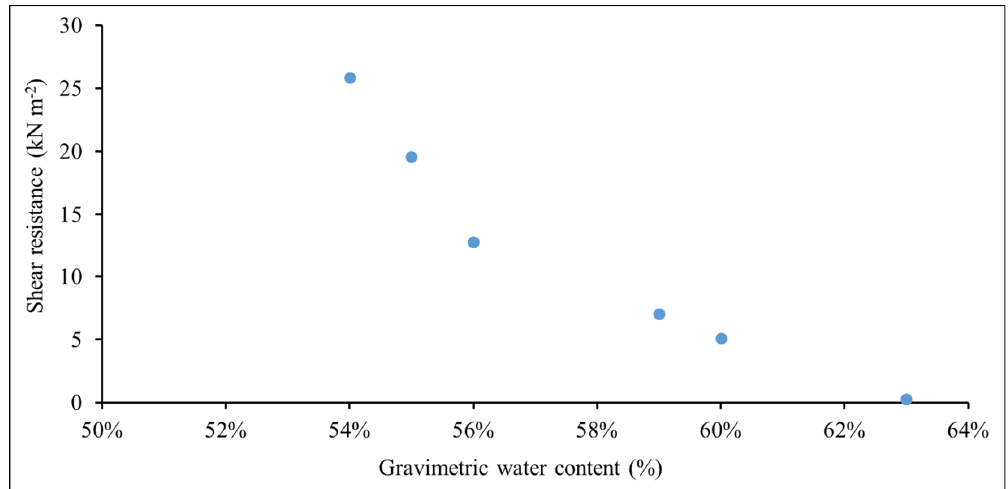
Figure 7. Vane shear strength of the bauxite residue versus its gravimetric water content.